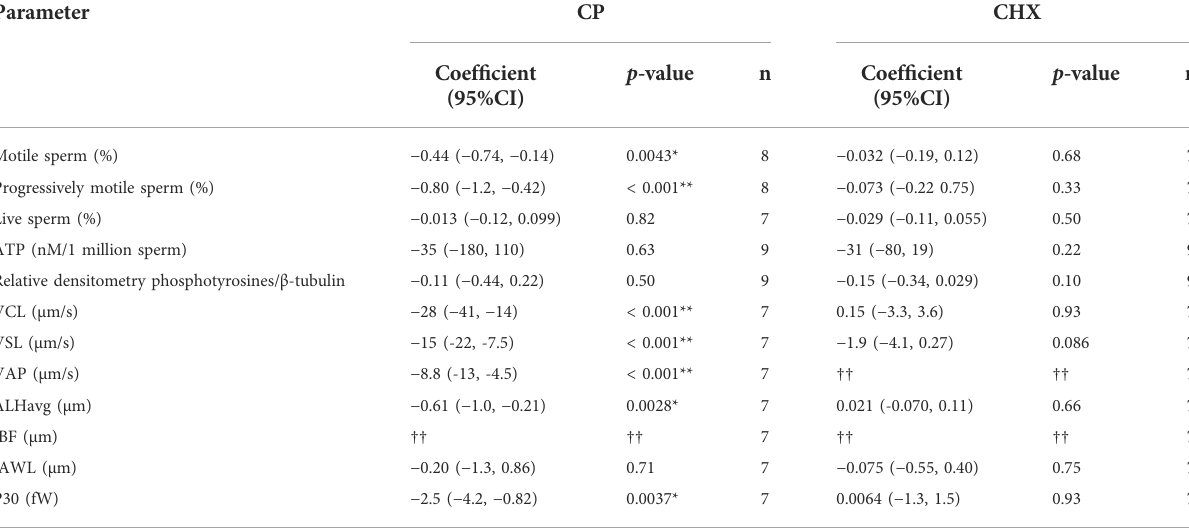
TABLE 1 In fl uence of mitochondrial (chloramphenicol, CP) and cytoplasmic (cycloheximide, CHX) ribosome inhibitors on sperm parameters, shown through fi tting linear mixed-effects models. The fi xed effect coef fi cient for concentration of inhibitors are shown with 95% con fi dence intervals and number of donors